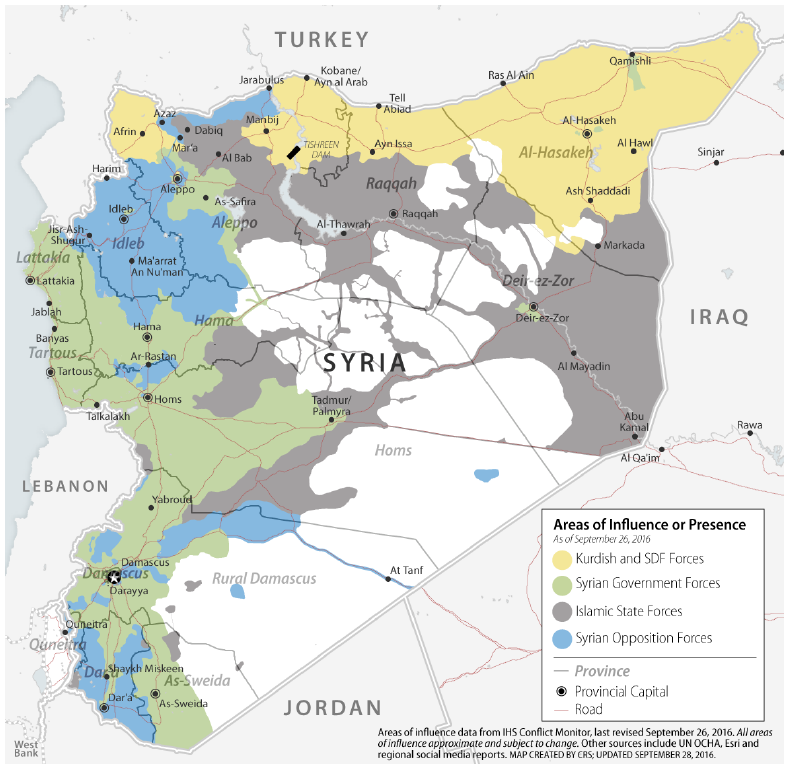
Figure 1: Areas of Influence or Presence (Source: Humud, Blanchard and Nikitin